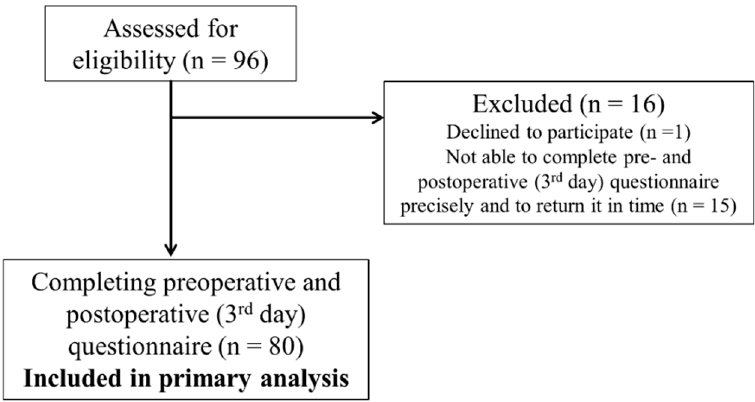
Figure 1. Flow of participating patients.